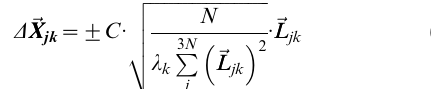
Figure S4 Structural plasticity of Phe43 Cavity. The atomic fluctuations are calculated using full atomic NMA in a solvent shell (see main text.). The gp120 cavity fluctuations for isolated, CD4, F23 and CD4M33-bound states in (A) mode 1, ( B) mode 2, (C) mode 3, (D) mode 4. View as ‘‘slide show’’ to visualize fluctuation